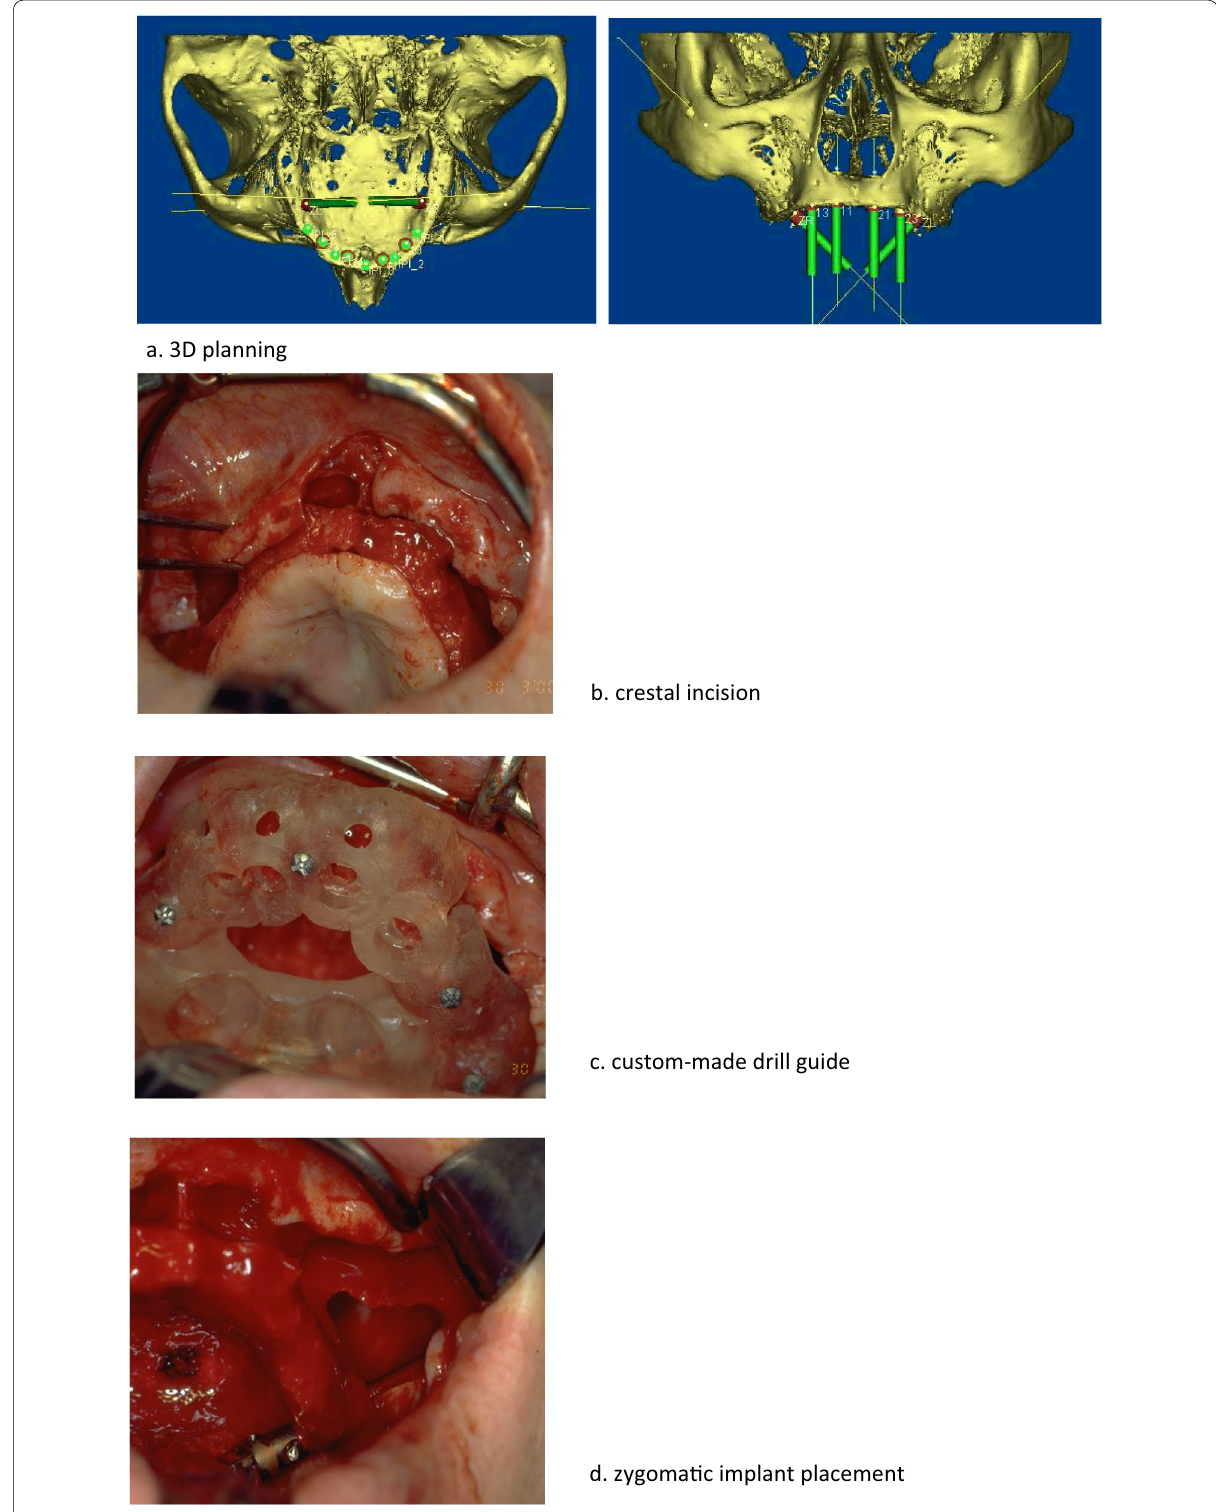
Fig. 1 a 3D planning. b Crestal incision. c Custom-made drill guide. d Zygomatic implant placement. e 1-year follow-up. f 5-year follow-up. g 10-year